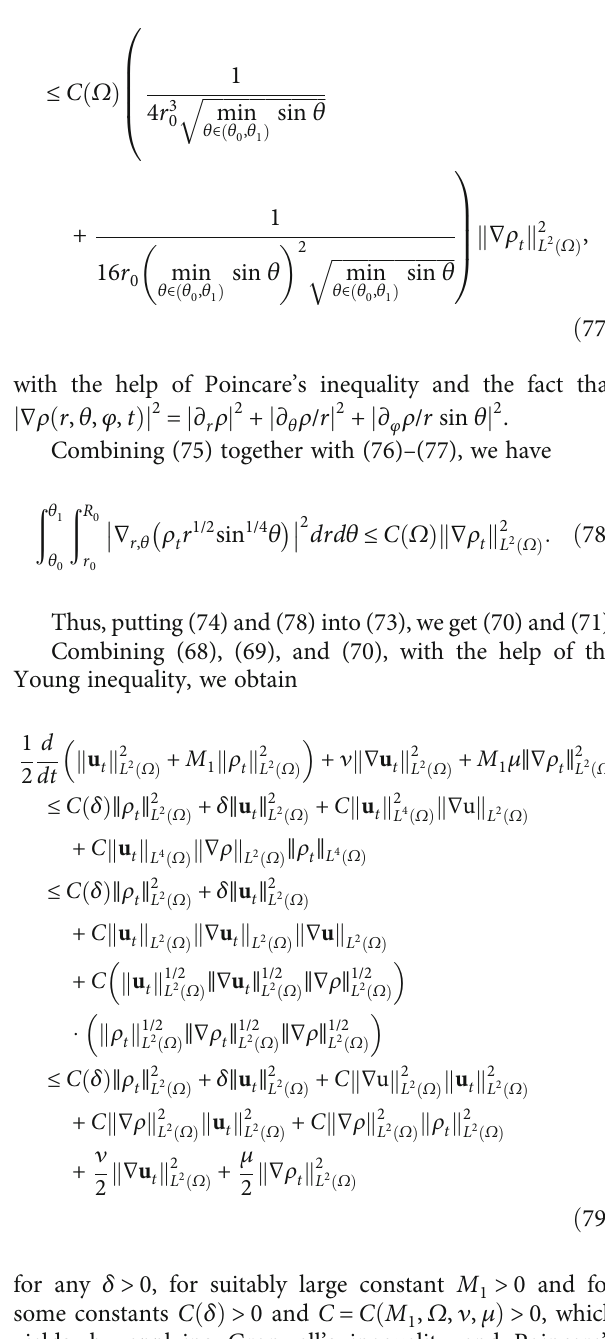
ffiffiffiffiffiffiffiffiffiffiffiffiffiffiffiffiffiffiffiffiffiffiffiffi min